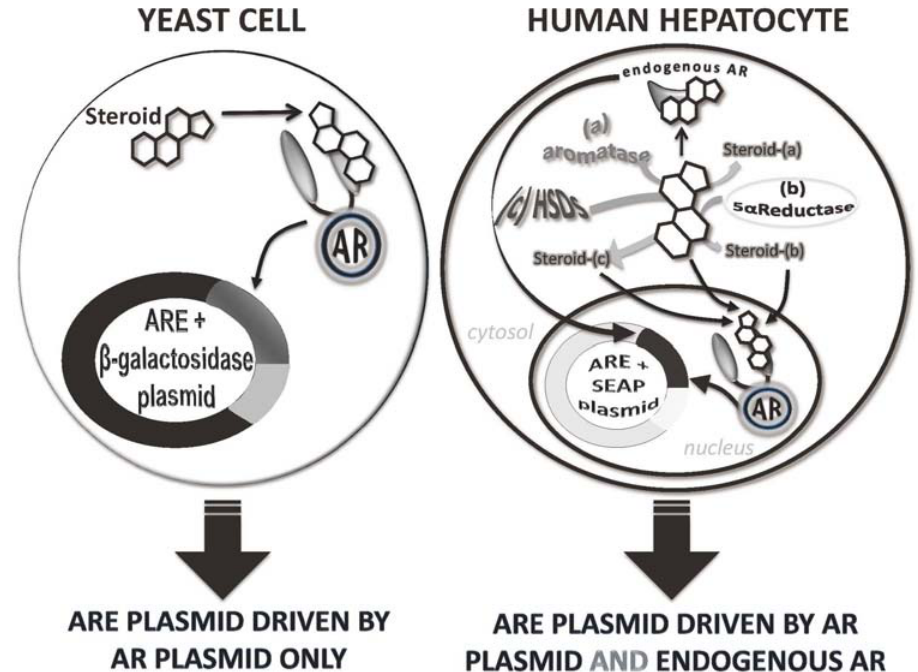
Figure 2. Yeast and mammalian cell-based androgen